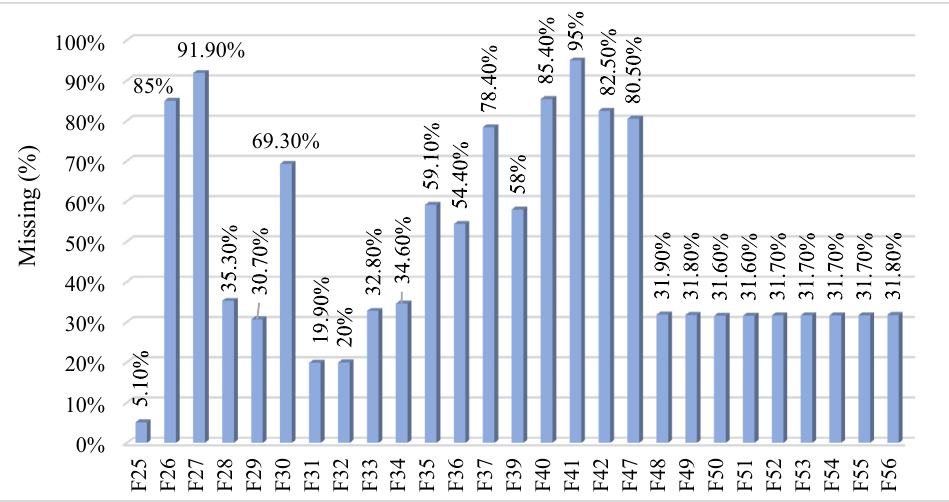
Figure 5. The MAR pattern analysis of the IRDia dataset.